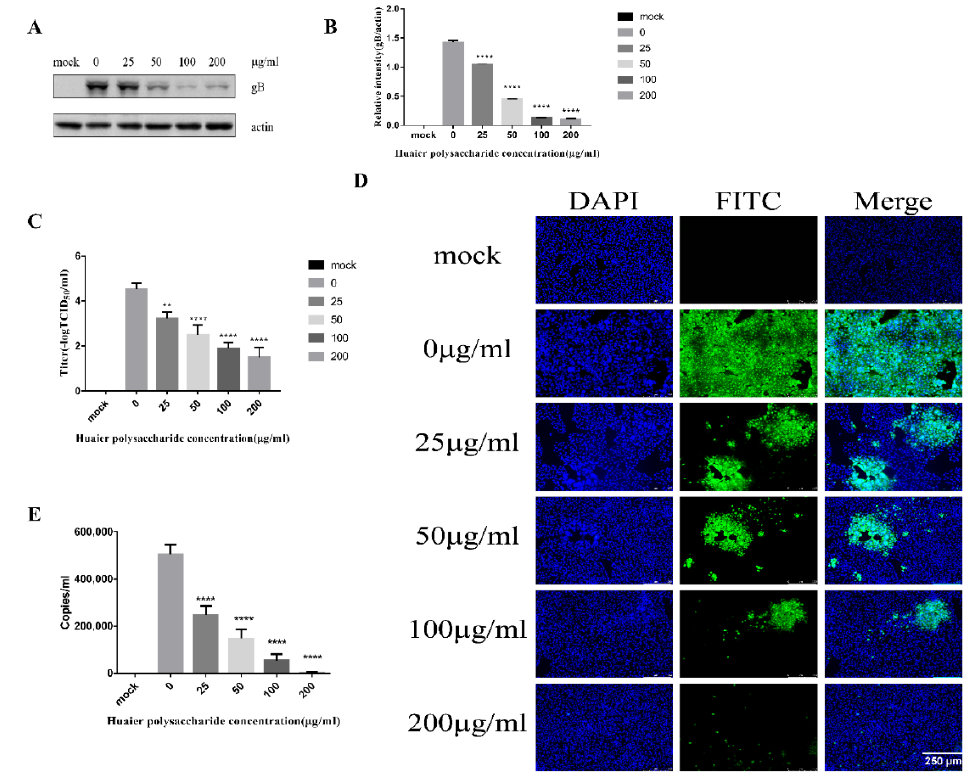
Figure 3. Huaier polysaccharide reduced PRV XJ5 adsorption and entry. The cells were treated according to the method described in Section 2.3.3. ( A ) Western blot showing changes in gB and actin expression. ( B ) The intensity band ratio of intracellular gB to actin. Data are presented as means from three independent statistical experiments. The intensities of protein bands were quantified using Image J. Significance was analyzed using one-tailed Student’s t -test. **** p < 0.0001. ( C ) The viral titers were evaluated through TCID 50 assay. ( D ) The numbers of cells infected with PRV were observed through IFA. ( E ) The virus DNA copies were observed through qRT-PCR after cells were washed with citric acid and PBS to remove uninternalized virus. ** p = 0.003, **** p < 0.0001. Data are shown as mean ± SD based on three independent experiments.